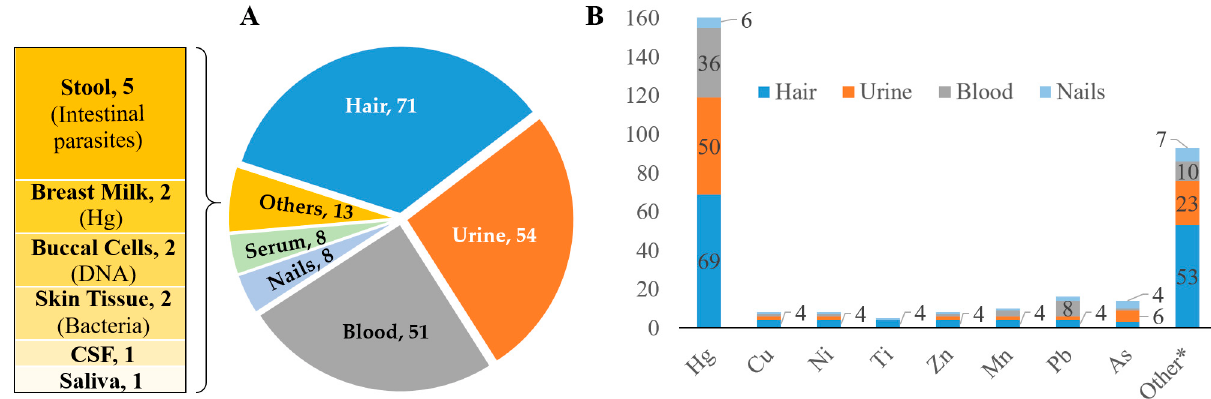
Figure 7. Human samples and biomarker profile. Investigated biomarkers include heavy metals and metalloids. Numbers are frequency of reporting articles. Panel ( A ), type of examined samples and Panel ( B ), type of investigated pollutants. Note: CSF, cerebrospinal fluid; DNA, deoxyribonucleic acid; Hg, mercury; Pb, lead; Zn, zinc; As, arsenic; Cu, copper; Ni, nickel; Mn, manganese; Ti, titanium; and ( * ) other chemical pollutants reported in few studies (e.g., 1 to 3 studies, each).